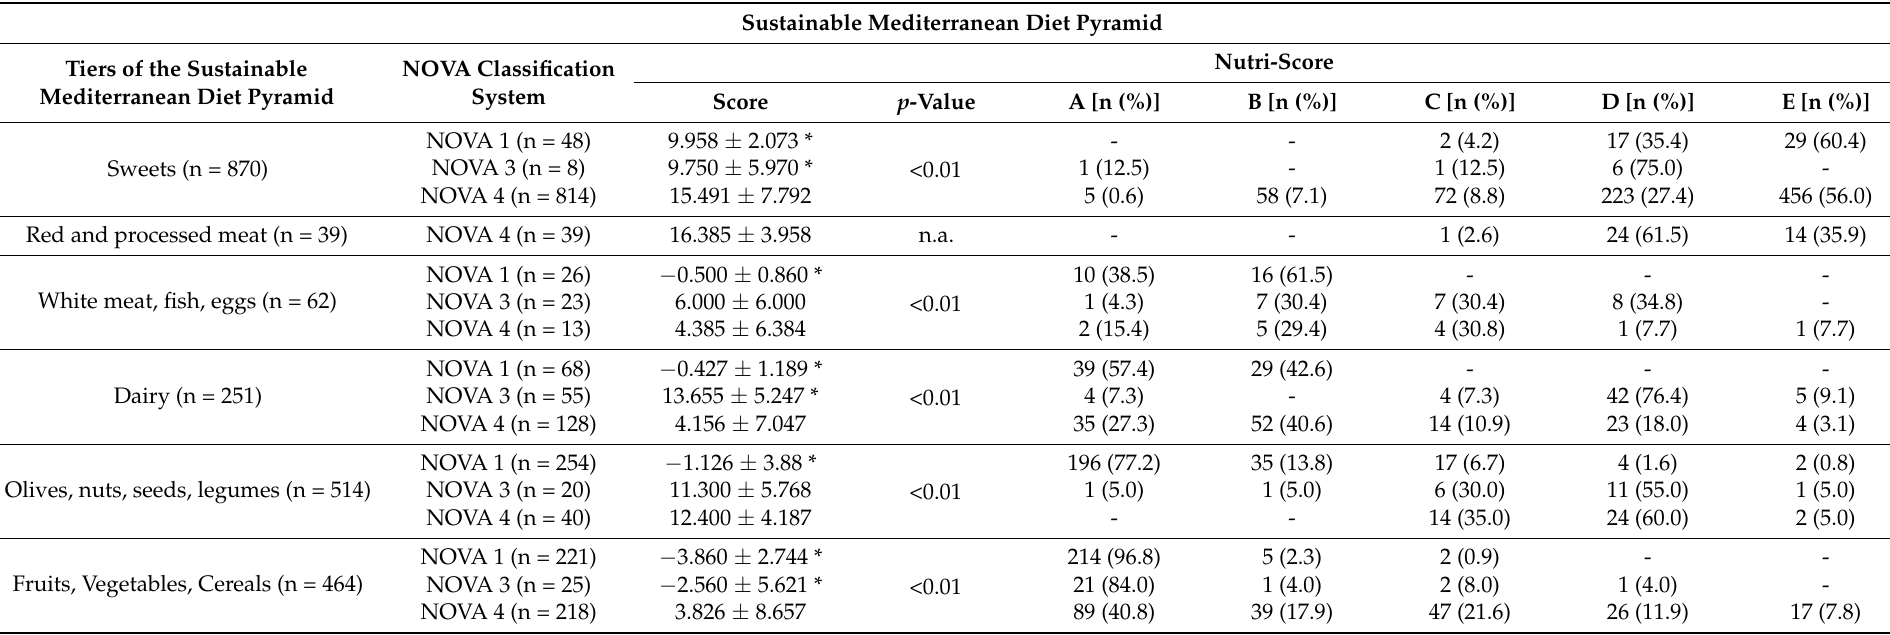
Table 7. The NOVA classification system, FSAm-NPS score, and distribution of the Nutri-Score grades across the sustainable MD pyramid’s